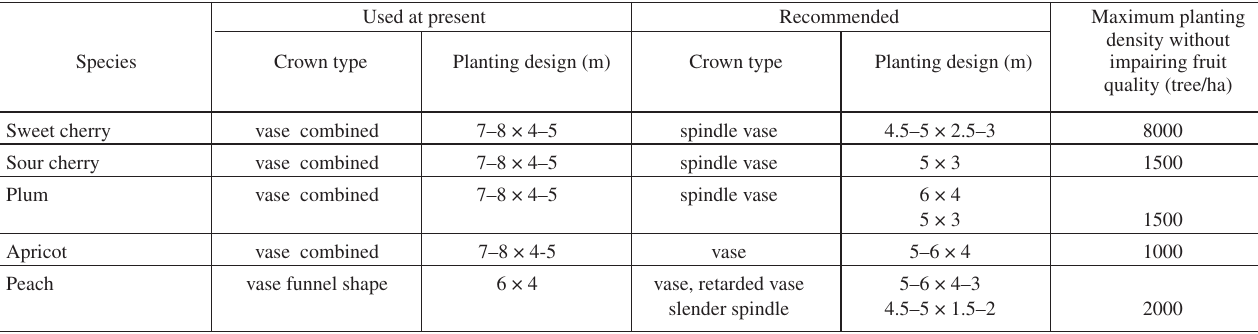
Table 7. Training of the crowns and planting designs of stone fruit plantations recommended in